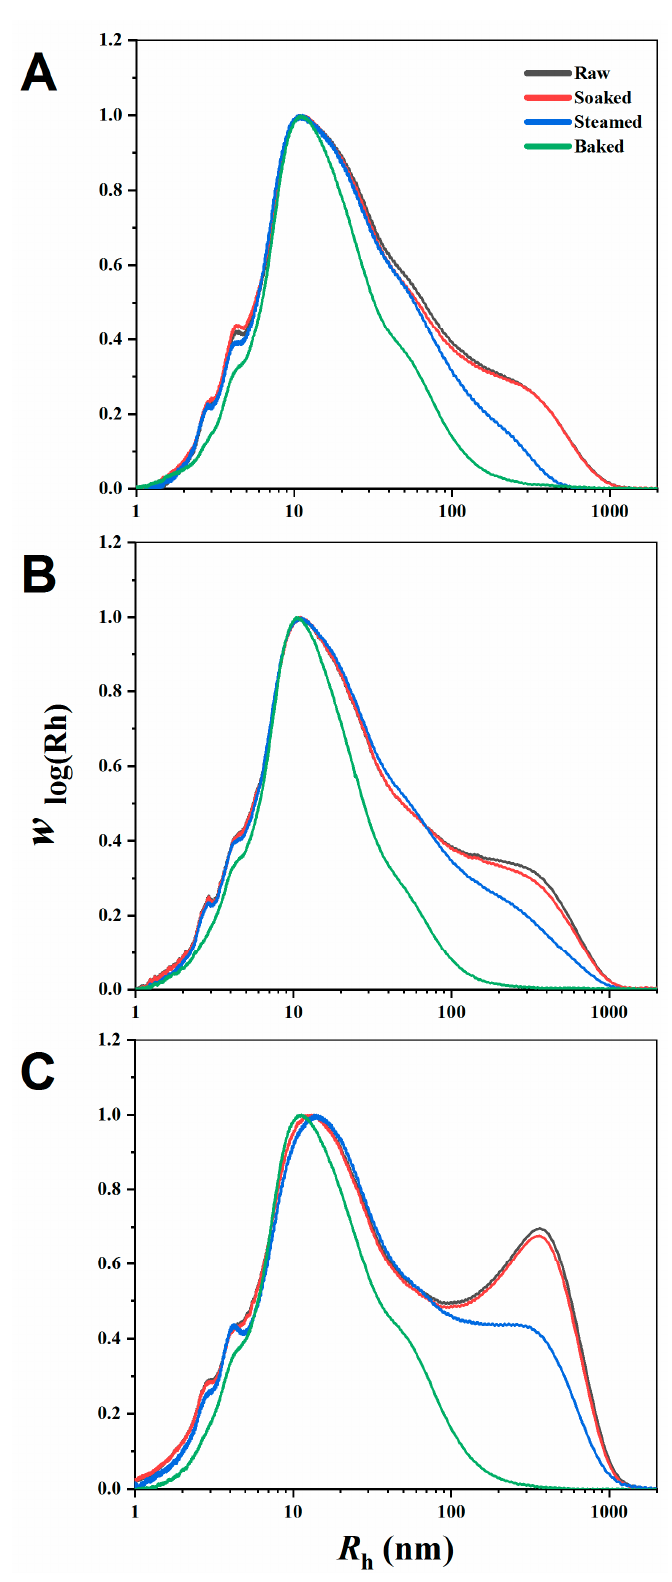
Figure 1. Molecular weight distribution of raw and different processed millet starch (soaked, steamed, and baked, respectively). ( A – C ) represents M1, M2, M3, respectively.